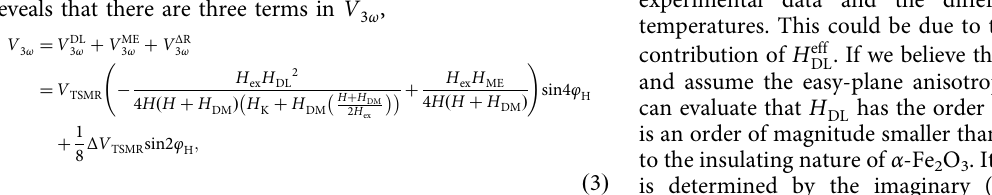
= 35 Oe, which is FL